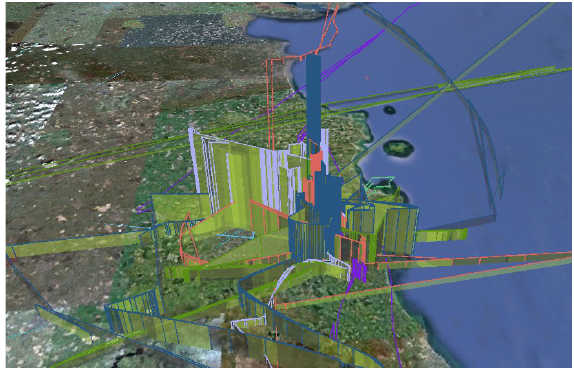
Figure 5: The trajectories representing task 9 shown in the Space Time Cube. The trajectories all converge on one location which represents the focus of this particular task and therefore the prime view